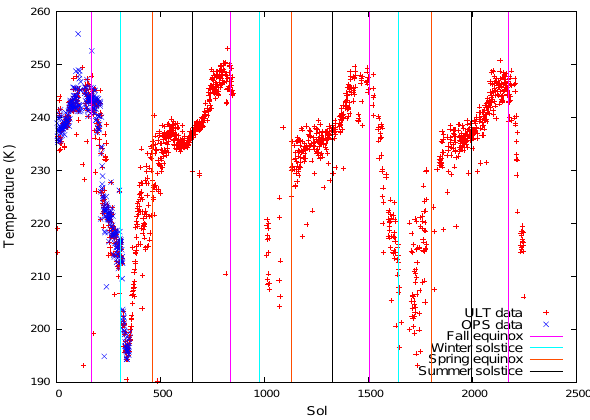
Fig. 2. ULT and OPS temperature data of all the VL1 sols, bin 12. Fig. 3. ULT VL1 noon, midnight and sol mean temperature data of the whole